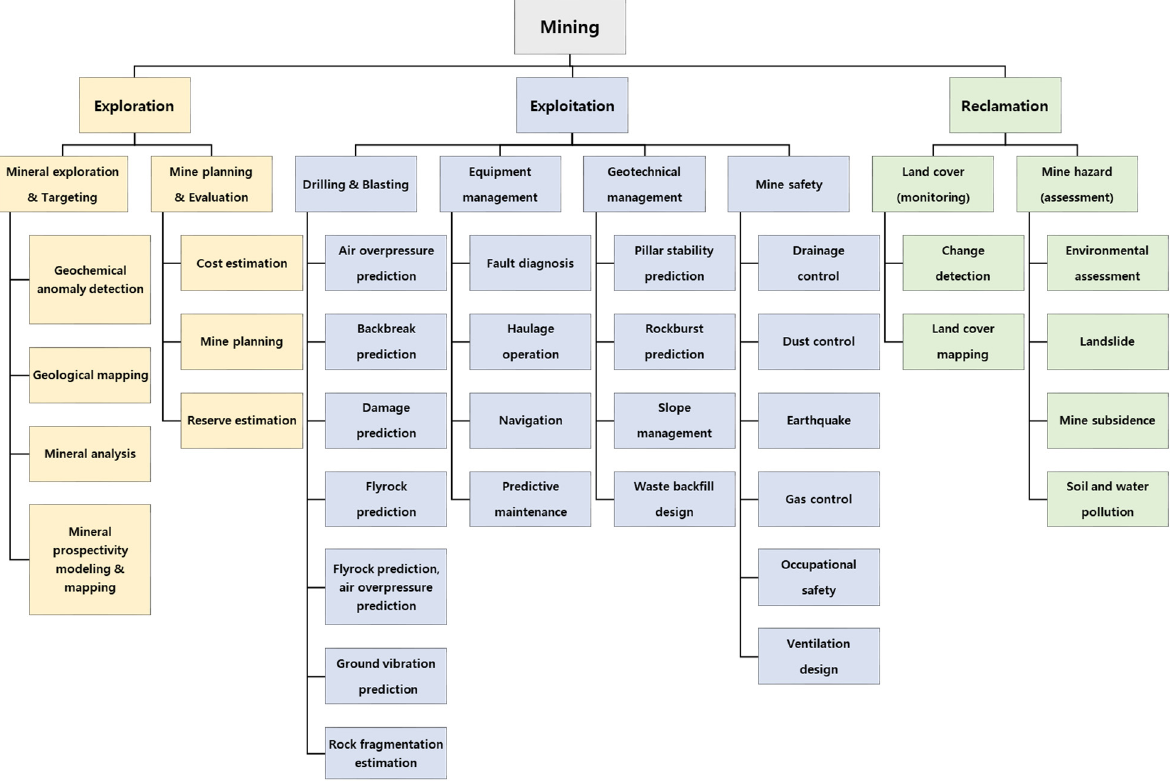
Figure 3. Research application fields.